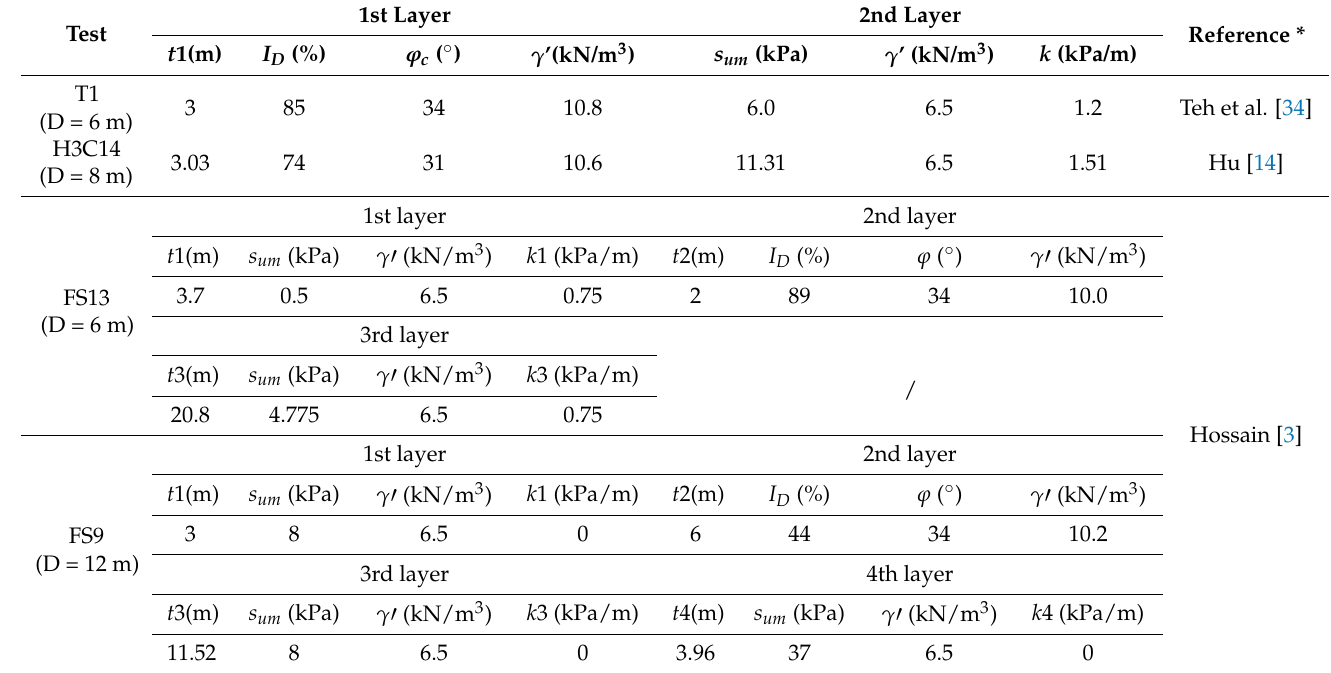
Table 1. Soil properties used in centrifuge tests.